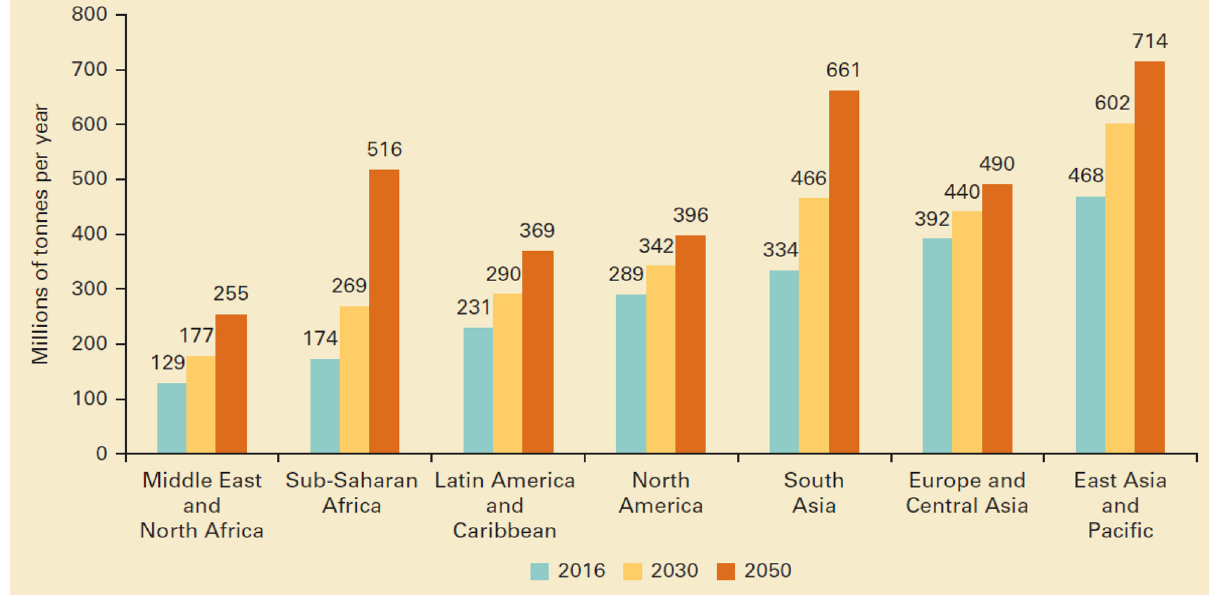
Figure 5: Amount of global waste materials generated in megatons ( MT ) per year as reported for 2016 and projected for 2030 and 2050 [ 7 ]